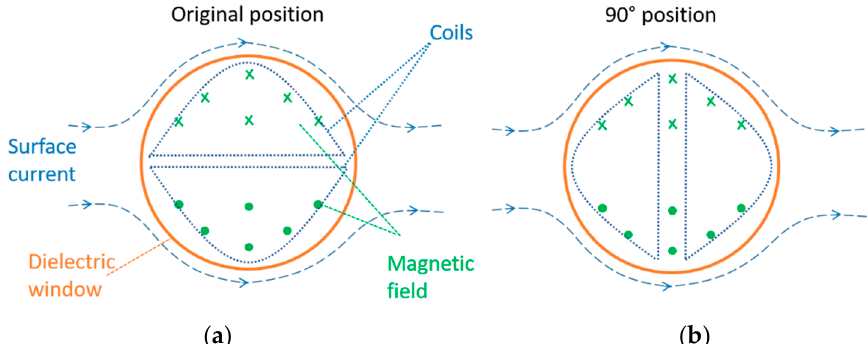
Figure 19. ( a ) Antenna in normal position. ( b ) Rotated antenna 90 degrees.